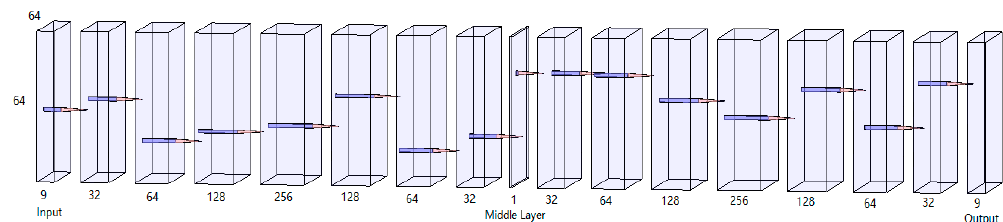
Figure 7. The proposed MAEN structure and comparison with the normal AEN structure (AEN - 9, AEN - 15).